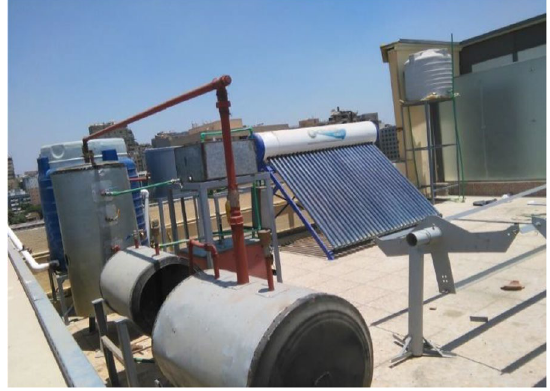
Fig. 16 Photographic view of a solar water desalination system using evacuated tube collector (El-Ghetany et al.